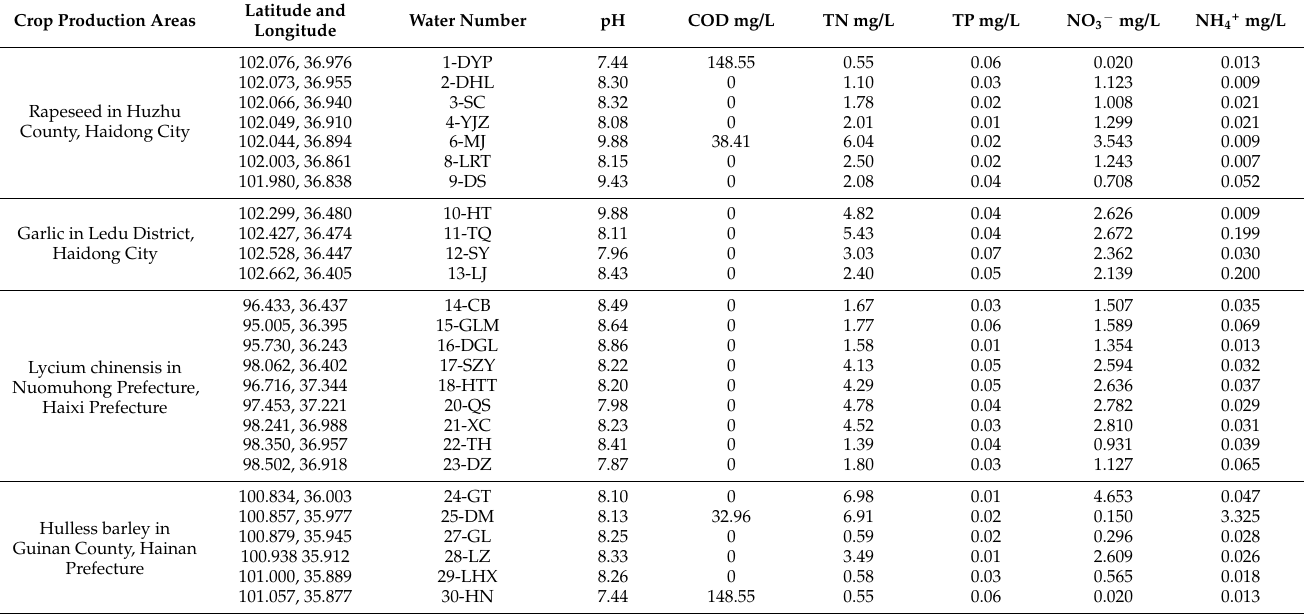
Table 1. Physicochemical indexes of water quality in typical crop-producing areas of Qinghai